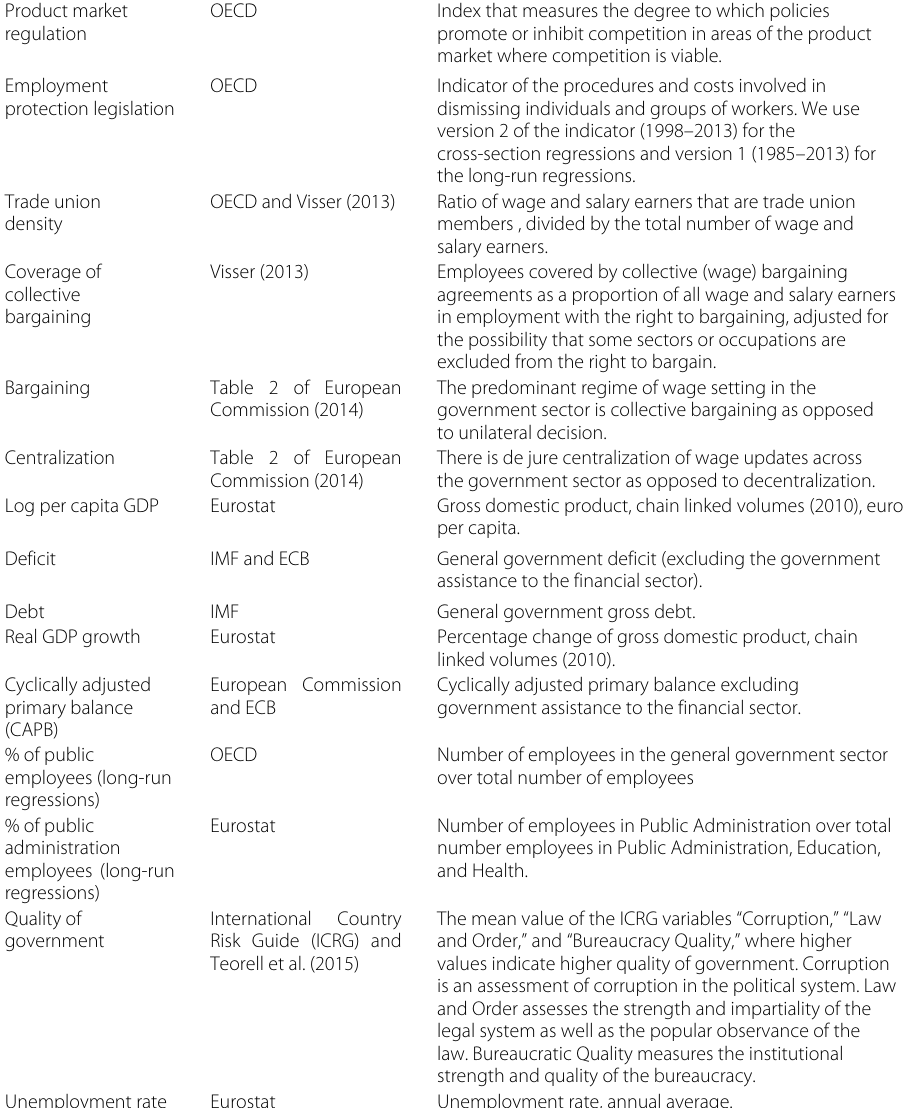
Table 7 Data: definitions and sources